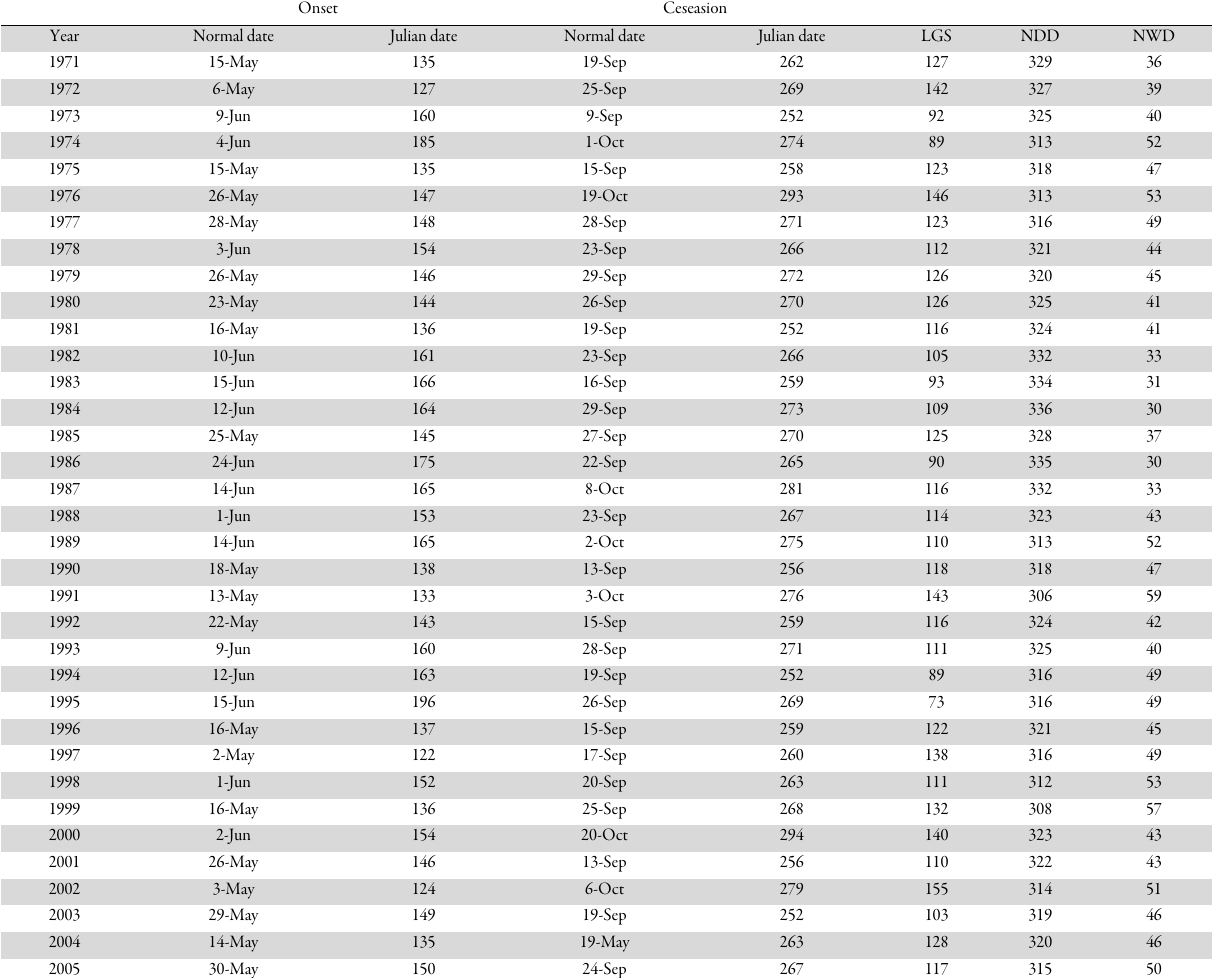
Table 5. Onset, cessation, length of growing season (LGS), number of dry days (NDD) and number of wet days (NWD) in Sokoto Onset